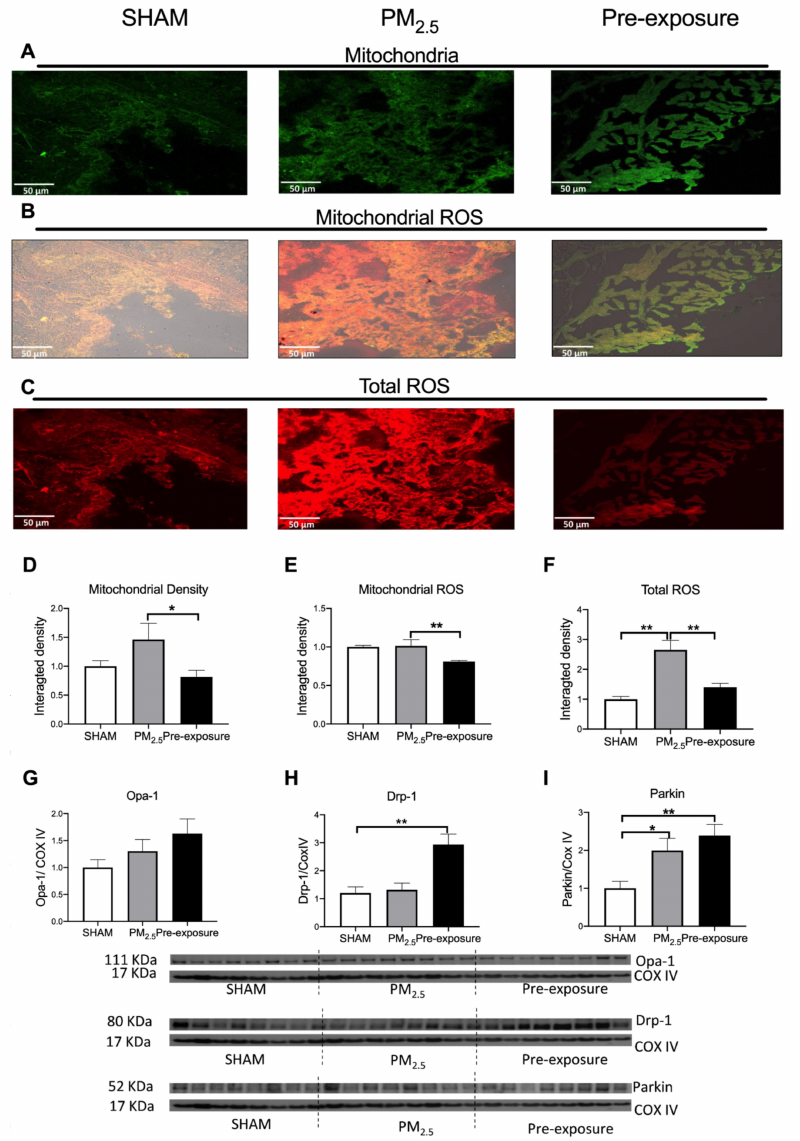
Figure 4. PM 2.5 exposure increased mitochondrial density and total ROS level in the dams. Represen- tative images of ( A ) mitochondria (green), ( B ) mitochondrial specific ROS (orange,) and ( C ) total ROS (red) staining, and ( D – F ) quantitative results. Protein levels of ( G ) Opa-1, ( H ) Drp-1 and ( I ) Parkin. Data were analysed by one-way ANOVA followed by Fisher’s LSD post hoc tests. N = 5 in mito- chondrial fluorescence staining, n = 8 in Western blot. * p < 0.05, ** p < 0.01. Drp-1, dynamin-related protein; Opa-1, optic atrophy-1; PM 2.5 : dams exposed to PM 2.5 (5 µ g/day) prior to mating for 6 weeks during gestation and lactation. Pre-exposure: dams exposed to PM 2.5 for 6 weeks prior to